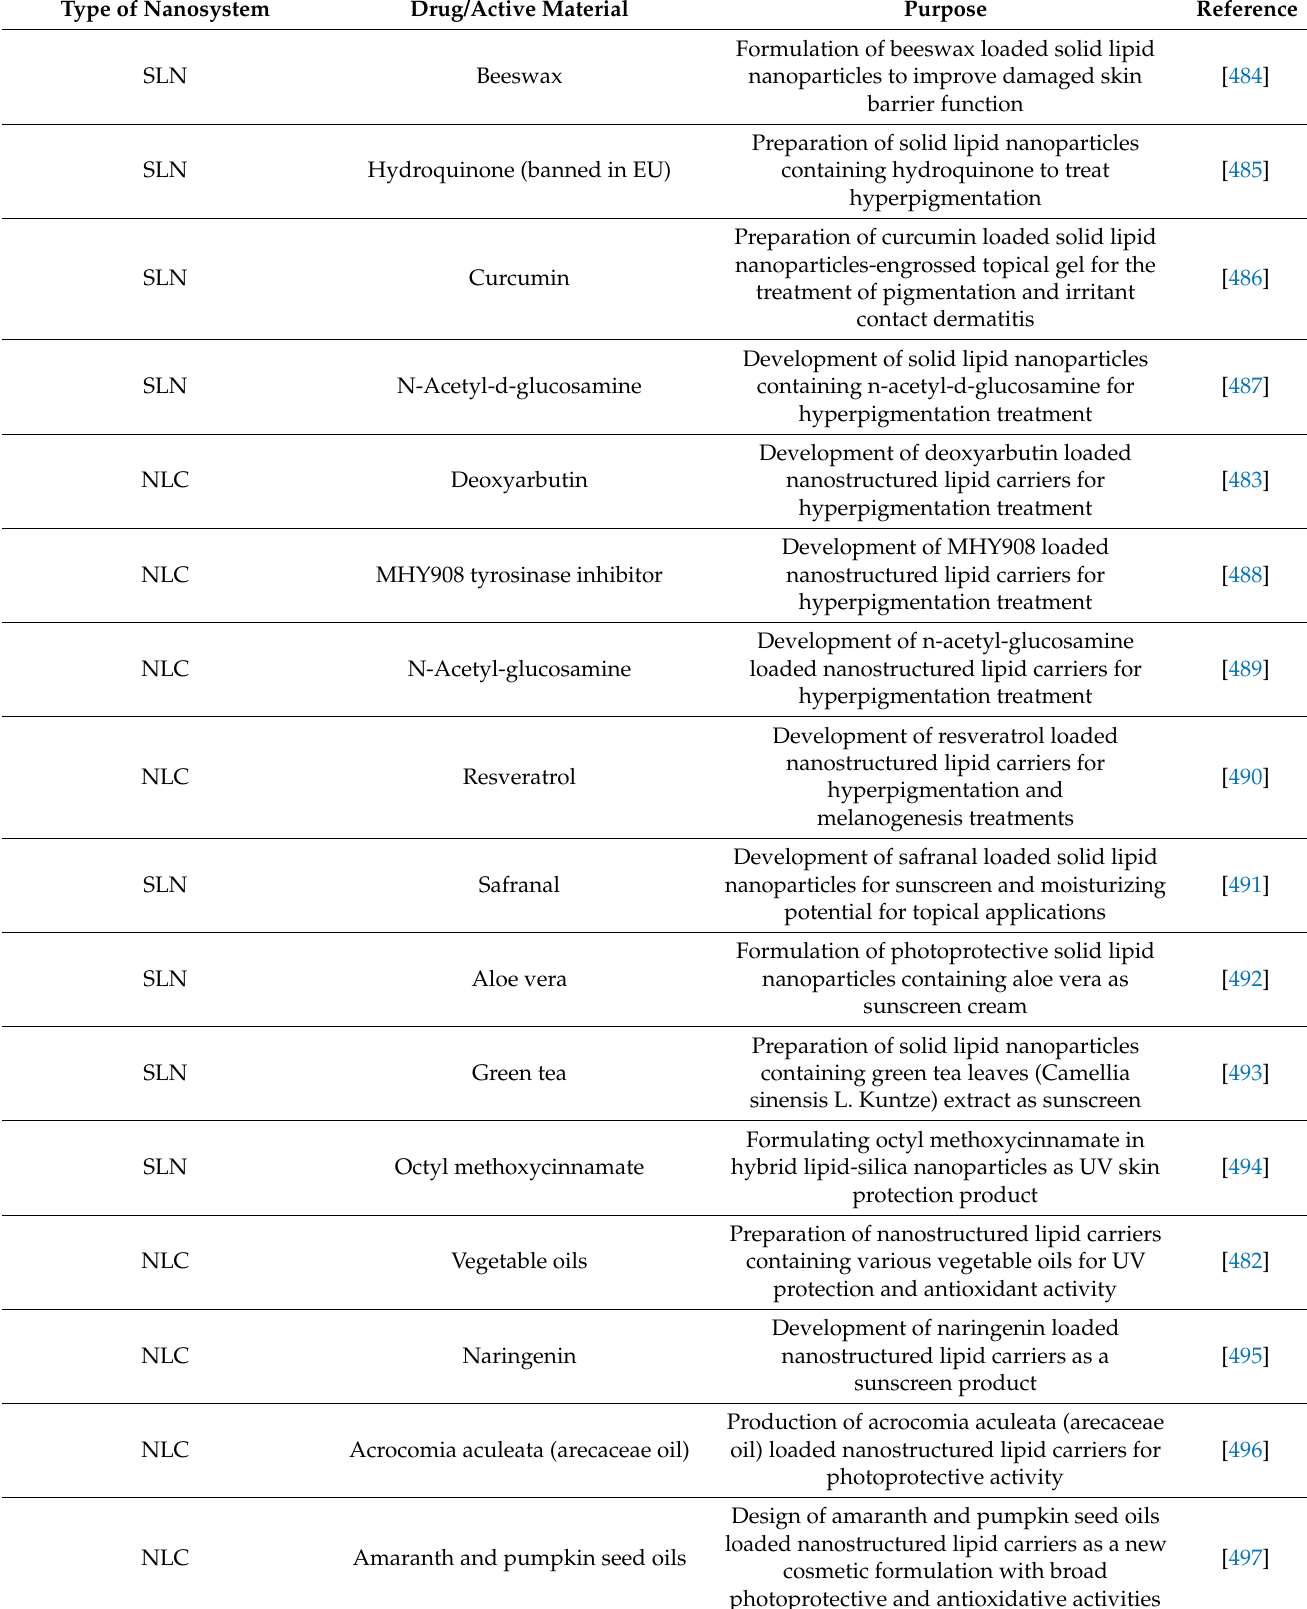
Table 5. Recent studies on nanoparticular cutaneous drug delivery systems in cosmetics and skincare. Type of